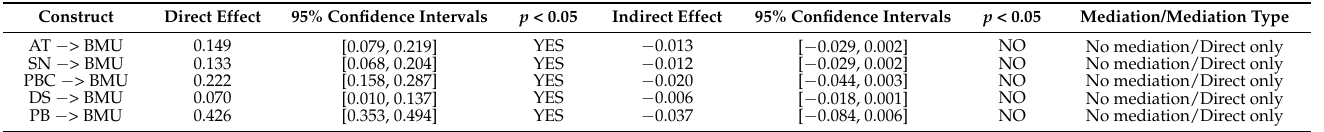
Table 9. Significance analysis of the direct and indirect effects (mediation